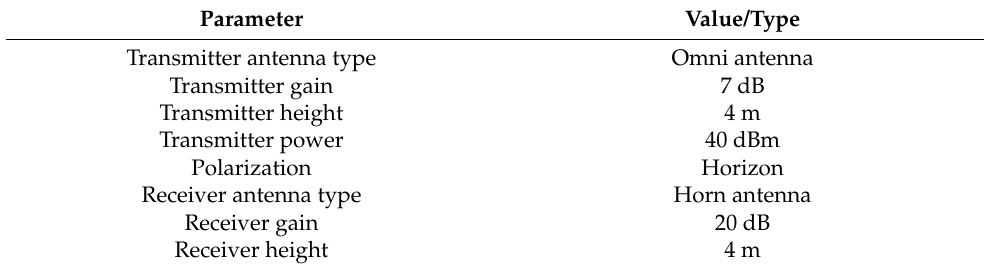
Figure 20. The simulation and measurement PL of the EM wave. The light pink box indicates the rainfall period. Table 5. Experiment configurations.